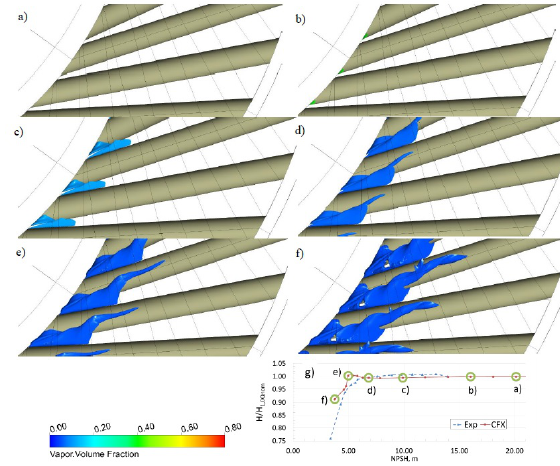
Figure 12: The process of the cavitation vortex development in the passages of the radial labyrinth pump for NPSH equals: a) 20.1 m; b) 16 m; c) 9.9 m; d) 6.8 m; f) 5 m; e) 3.8 m; g) the comparison of